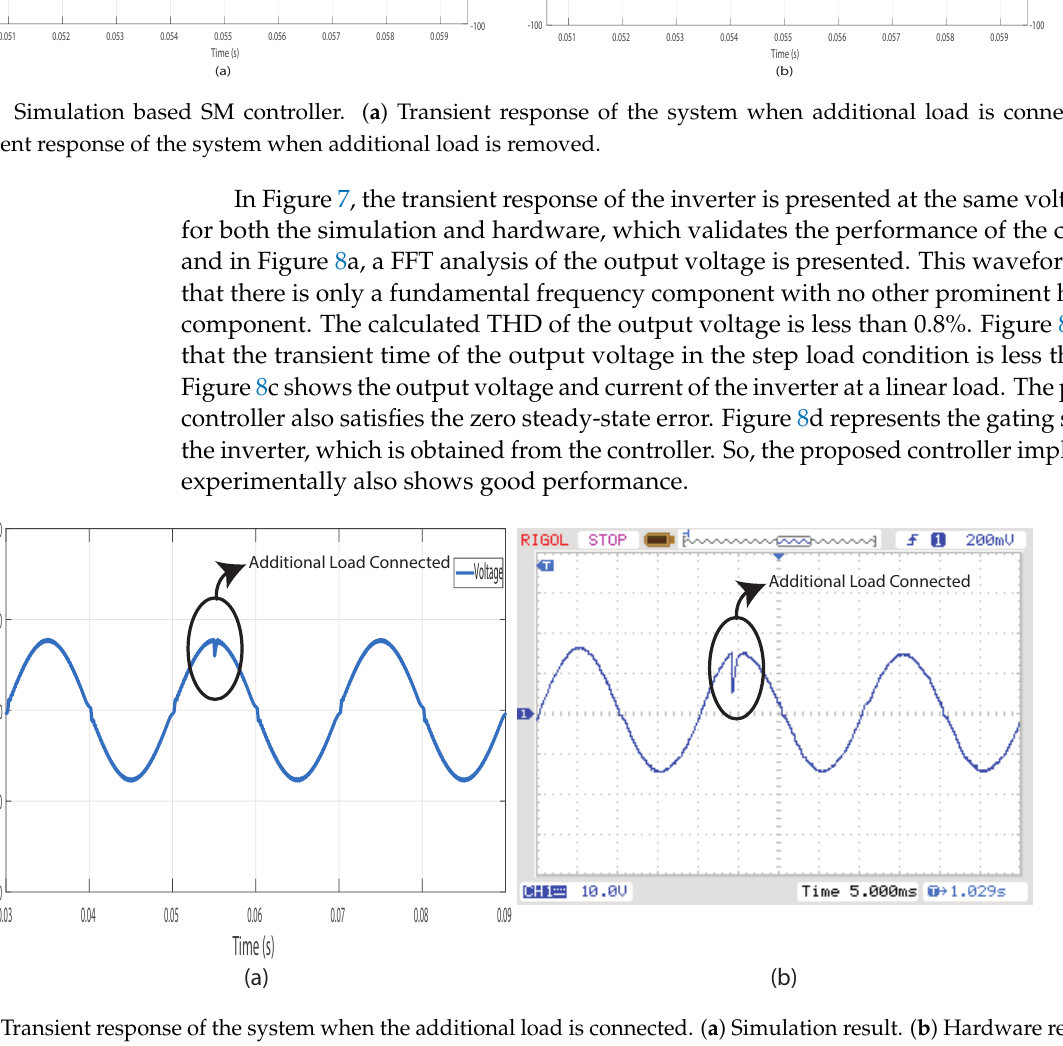
Figure 7. Transient response of the system when the additional load is connected. ( a ) Simulation result. ( b ) Hardware